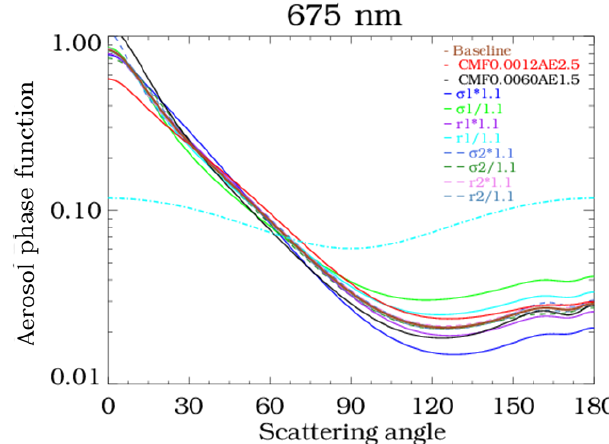
Figure 13. Aerosol phase function sensitivity to perturbations of the aerosol size distribution, using the V1 aerosol size distribu- tion as a baseline. Note that the ± 10% perturbations of r 1 ,σ 1 ,r 2 , and σ 2 also involved adjustments of f c to keep α ≈ 2. Two other perturbations are shown, in which the values of r 1 ,σ 1 ,r 2 , and σ 2 remain at the V1 aerosol size distribution values, but f c is var- ied: CMF0.0012AE2.5 (red line) indicates that f c = 0 . 0012 (pro- ducing α = 2 . 5), and CMF0.0060AE1.5 (black line) indicates that f c = 0 . 06 (producing α = 1 . 5)